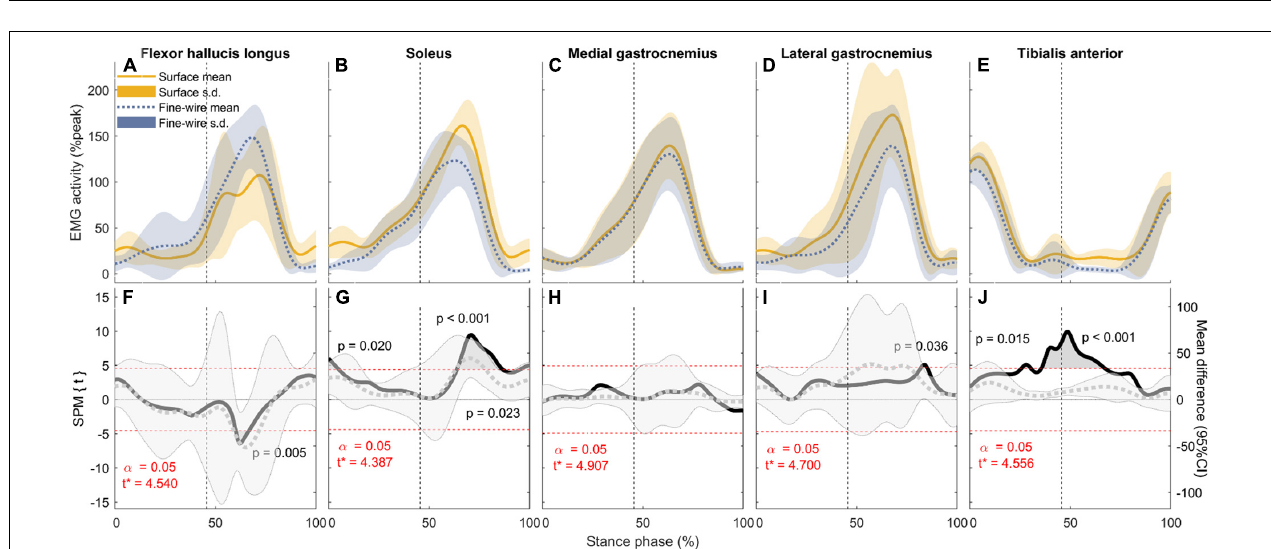
FIGURE 6 | Electromyography (EMG) activity (mean and standard deviation) of each muscle ( A–E : normalised to peak activity in preferred speed walking, %peak) and the corresponding comparisons between surface and intramuscular EMG recordings (F–J) in the stance phase of maximum speed walking (2.20 ± 0.38 m s − 1 ). Vertical dotted lines represent the beginning of push-off. Panels (F–J) SPM{ t } statistics for two-tailed t -tests (solid black lines, left y -axis), and mean difference with 95% confidence intervals (grey dotted lines with shaded areas). Dashed red lines are critical thresholds ( t ∗ ) calculated for α significance level defining supra-threshold clusters for SPM{ t } trajectories. P -values were calculated for each supra-threshold